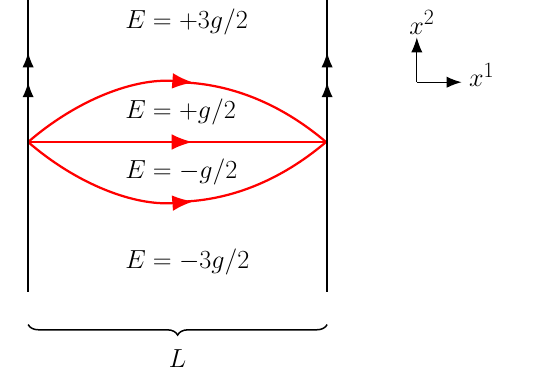
Figure 18. A proposed “lime wedge” instanton contributing to h +3 g/ 2 | − 3 g/ 2 i